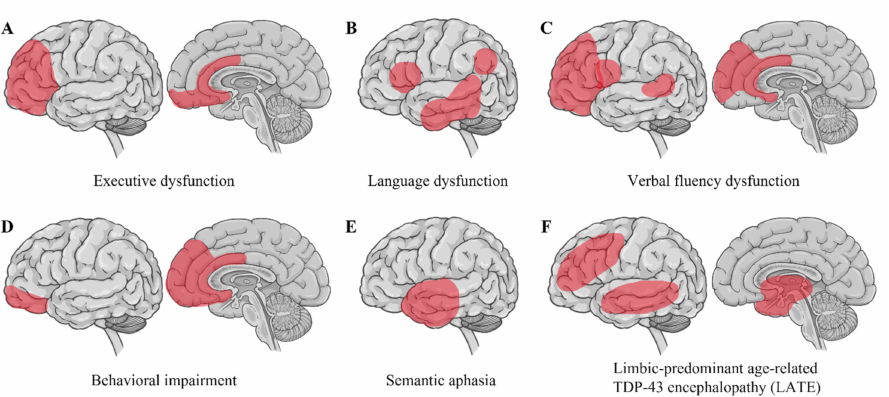
Figure 3. The distributions of TDP-43 pathology in the extra motor regions. The distribution of TDP-43 pathology in ALS-FTLD differs depending on the clinical types of cognitive impairments, such as: ( A ) executive dysfunction; ( B ) language dysfunction; ( C ) verbal fluency dysfunction; ( D ) behavioral dysfunction; and ( E ) semantic aphasia. Furthermore, ( F ) Limbic-predominant age-related TDP-43 encephalopathy (LATE) exhibits TDP-43 pathology in the limbic system, the frontal lobe, and the temporal lobe. The red areas show the distributions of TDP-43 pathology in the cerebrum. TDP-43 inclusions in frontal and anterior temporal lobe regions are detected in a subgroup of FTLD, named FTLD with TDP-43 (FTLD-TDP). FTLD-TDP accounts for